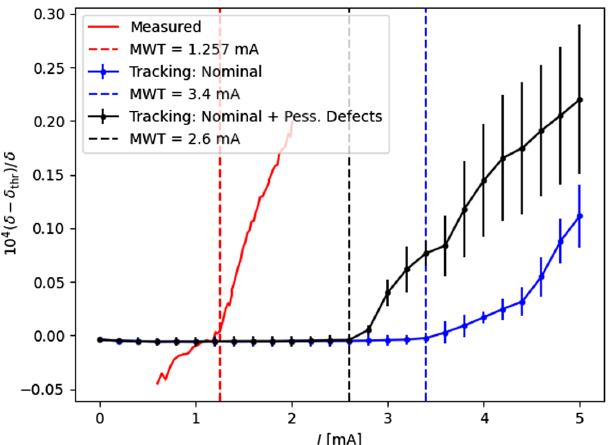
FIG. 5. Measurements and simulations showing the microwave instability, where the dashed line indicates the threshold in each case. The red is data that were measured on the SR, the blue is PyAT tracking with the nominal wake potential, and the black is from PyAT tracking with the wake potential model that includes pessimistic welding defects.